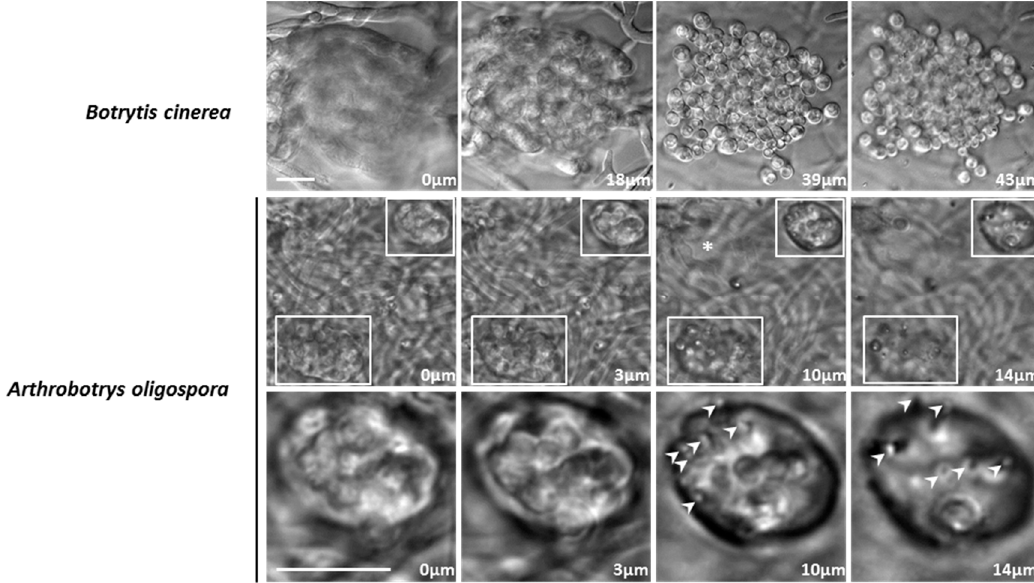
Figure 6. Botrytis Cinerea and Orbiliomycetes Arthrobotrys oligospora develop infection cushions. From left to right, the four columns represent successive z-planes of the same field of view. The distances from the initial z-plane are indicated. Upper row: when grown on cellophane, B . cinerea develops penetration cushions composed of a bundle of hyphae growing together transversally to the cellophane layer. Second row: comparably to B . cinerea , in A . oligospora , bundles of hyphae (from 2 to 20) can grow transversally to the cellophane layer, creating an infection cushion ( upper and bottom frames). The last row corresponds to the 3 × magnification of the infection cushion in the upper frame. Penetration pegs (arrow heads) at the tip of the hyphae compose the infection cushions. (*) Haustorium-like growth. In contrast to B . cinerea , hyphae of A . oligospora can be observed inside the cellophane layer. Scale bar = 10 µm.